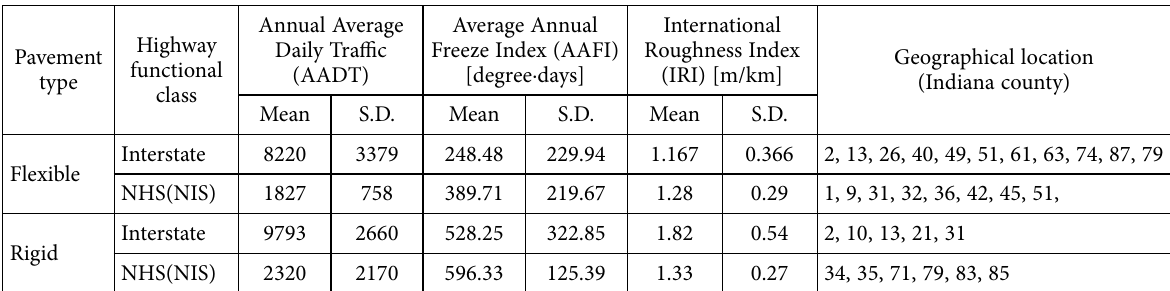
Table 1. Summary statistics of key